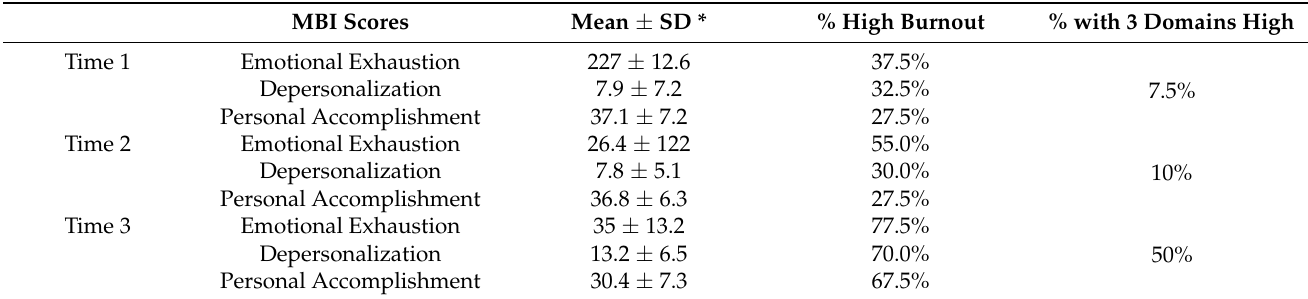
Table 2. MBI mean scores, prevalence.